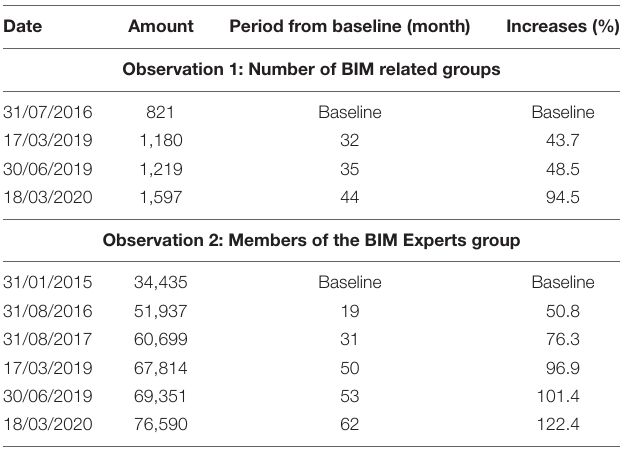
TABLE 1 | BIM related observations on